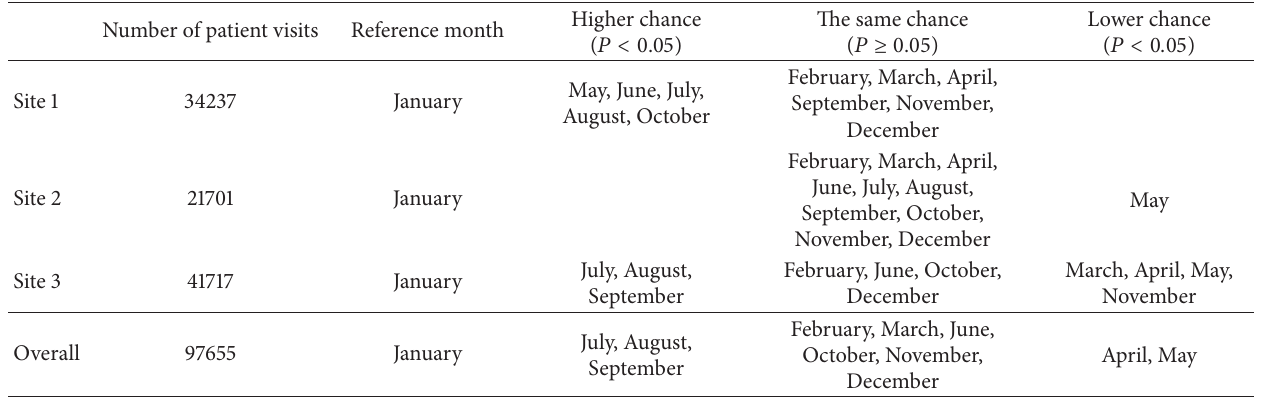
Table 4: Adjusted odds ratio of HIV testing by month of patient arrival in the ED categorized by site. Number of patient visits Reference